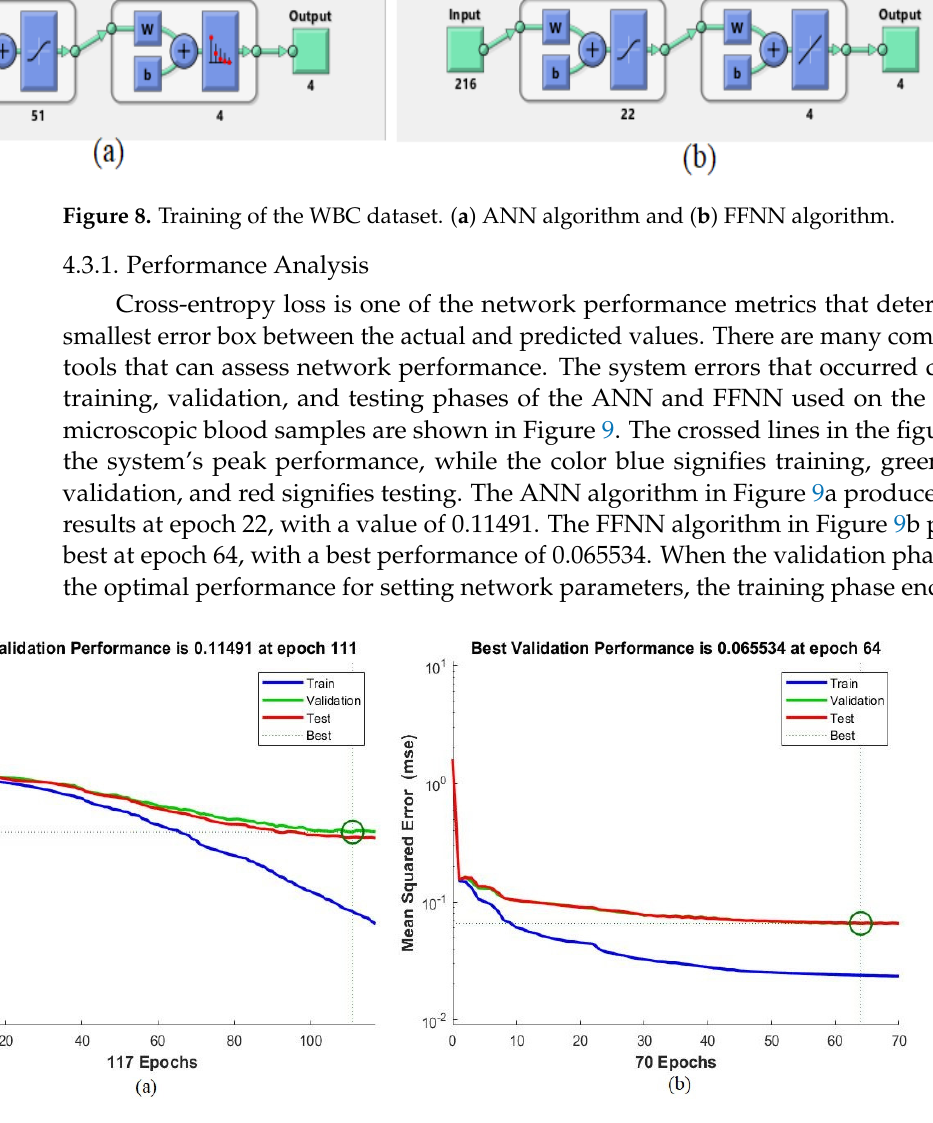
Figure 9. Performance diagram showing the training of the microscopic blood sample dataset. ( a ) ANN algorithm and ( b ) FFNN algorithm.